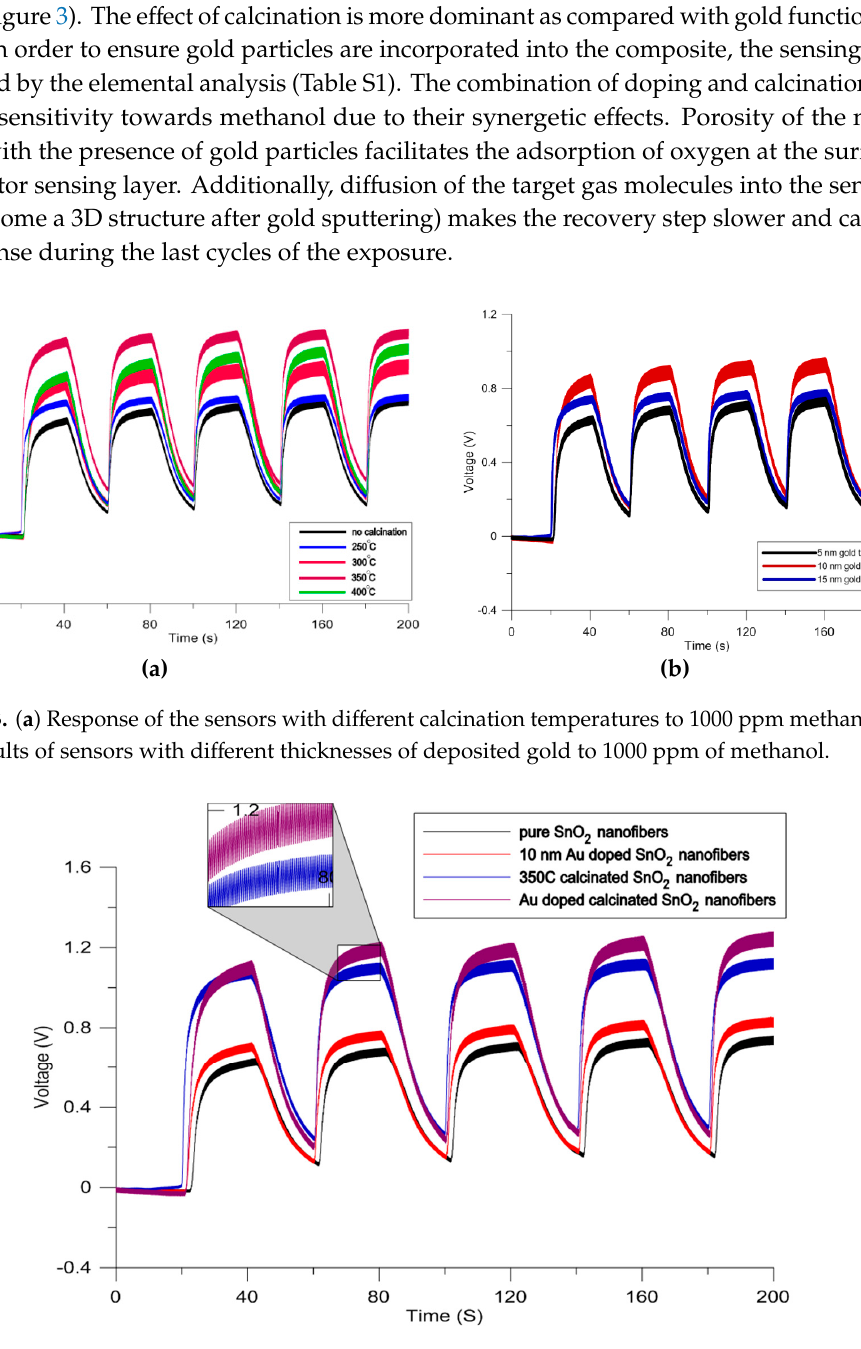
Figure 2. SEM images of the sensing layer after calcination for four hours at ( a ) 300 °C; ( b ) 400 °C; and ( c ) infrared spectra of the composite used as sensing layer.